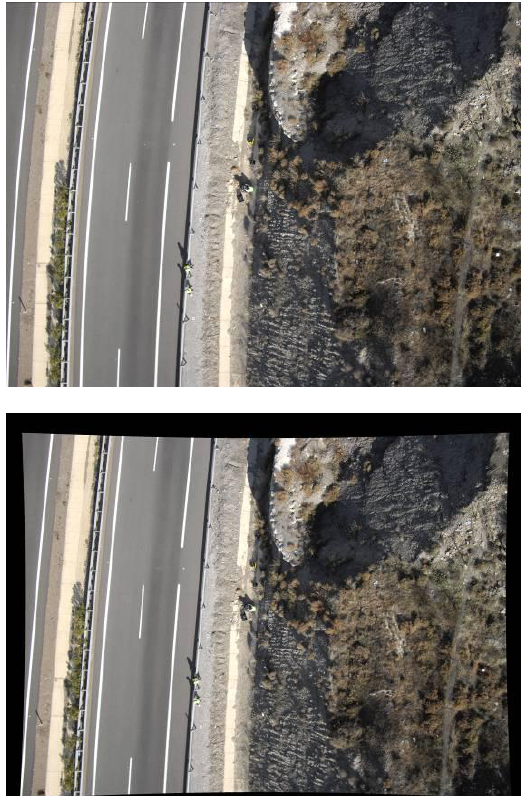
Figure 7. Upper image is one of the original photos taken on the outdoor work. The lower one is the same photo after distortion error